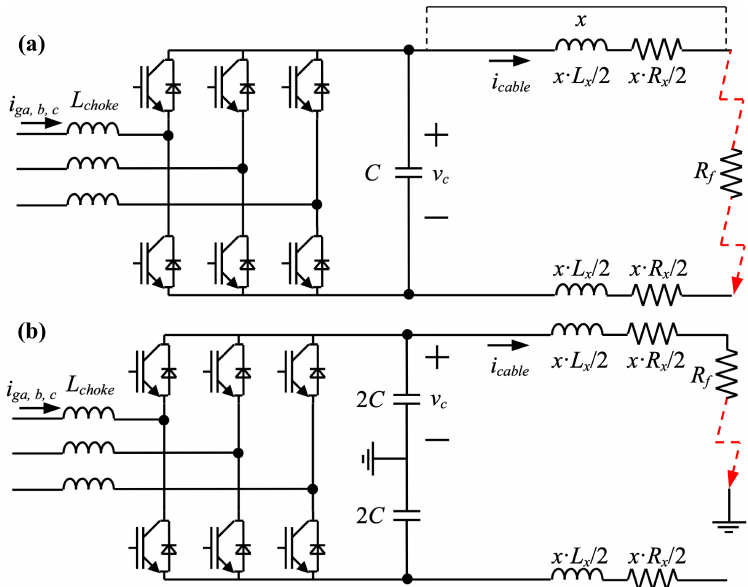
Figure 2. Circuit diagrams of simulated cable faults in VSC DC systems: ( a ) Pole-to-pole short circuits. ( b ) Pole- to-ground short circuits. For those faults Mesas et al. [9] have provided simulation models using solutions of differential equations. x —location of fault, L x —distributed inductance, R x —distributed resistance, C —capacitance of DC link capacitor, R f —fault resistance, v c —DC-link capacitor voltage, i cable —cable current, L choke is the grid-side choke inductance, i ga , b , c —IGBT currents. ( a )